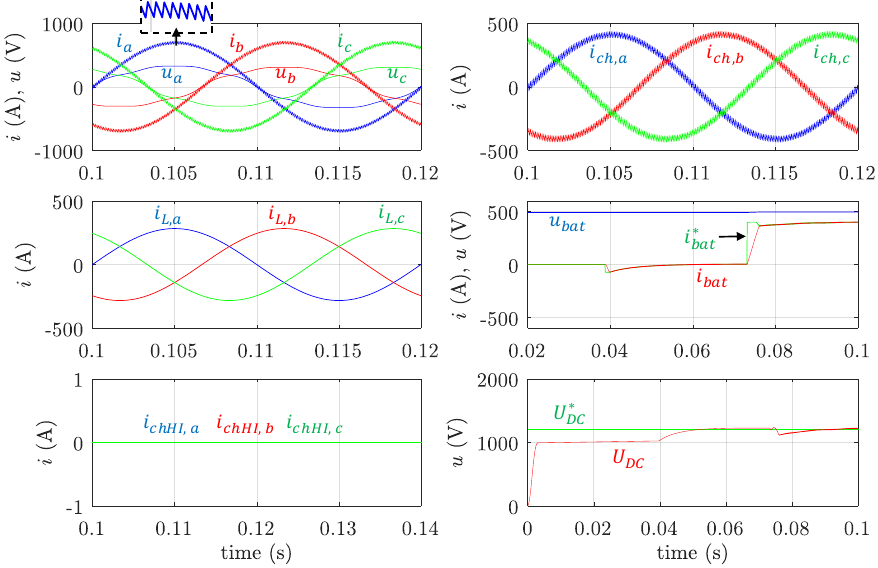
Figure 5. Simulation results. Case A. Charging the EV battery at maximum power: P ∗ = 200 kW. CS Figure 5 . Simulation results. Case A. Charging the EV battery at maximum power: 𝑃 ∗ = 200 kW. CS demand without harmonics nor imbalance: 𝐼 𝐿 = 200 A. demand without harmonics nor imbalance: I L = 200